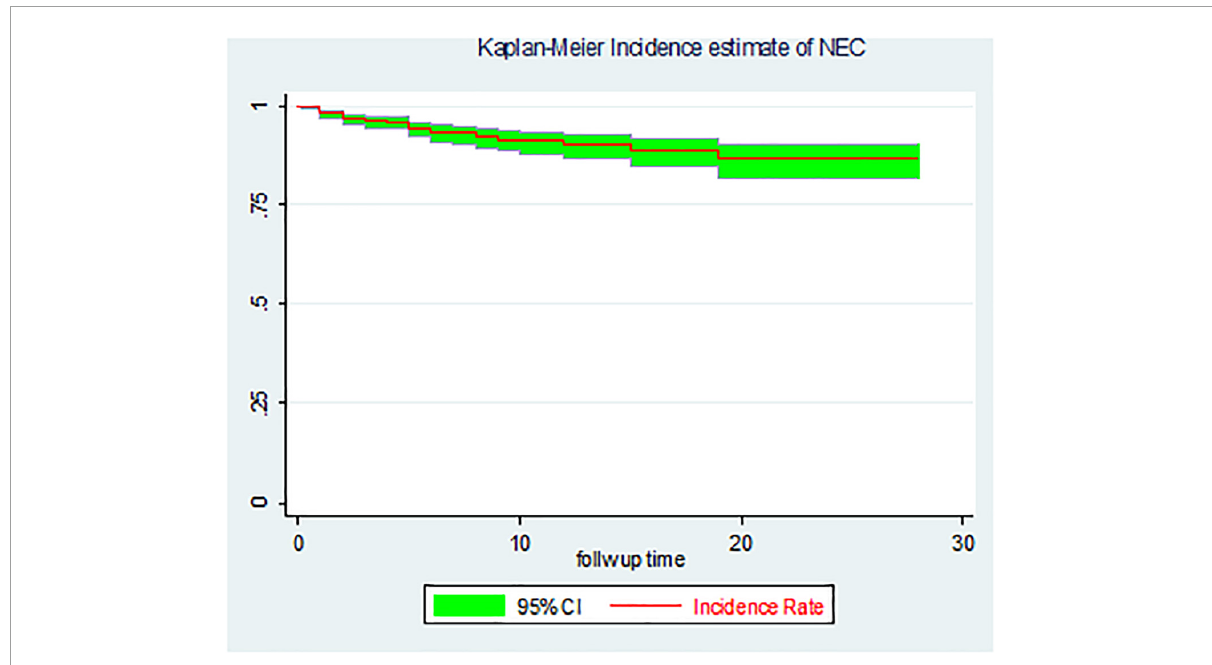
FIGURE2 The overall Kaplan–Meier incidence estimate of necrotizing enterocolitis (NEC) among LBW neonates admitted to the NICU of FHCSH, Ethiopia from 1 January 2015 to 30 December 2019.